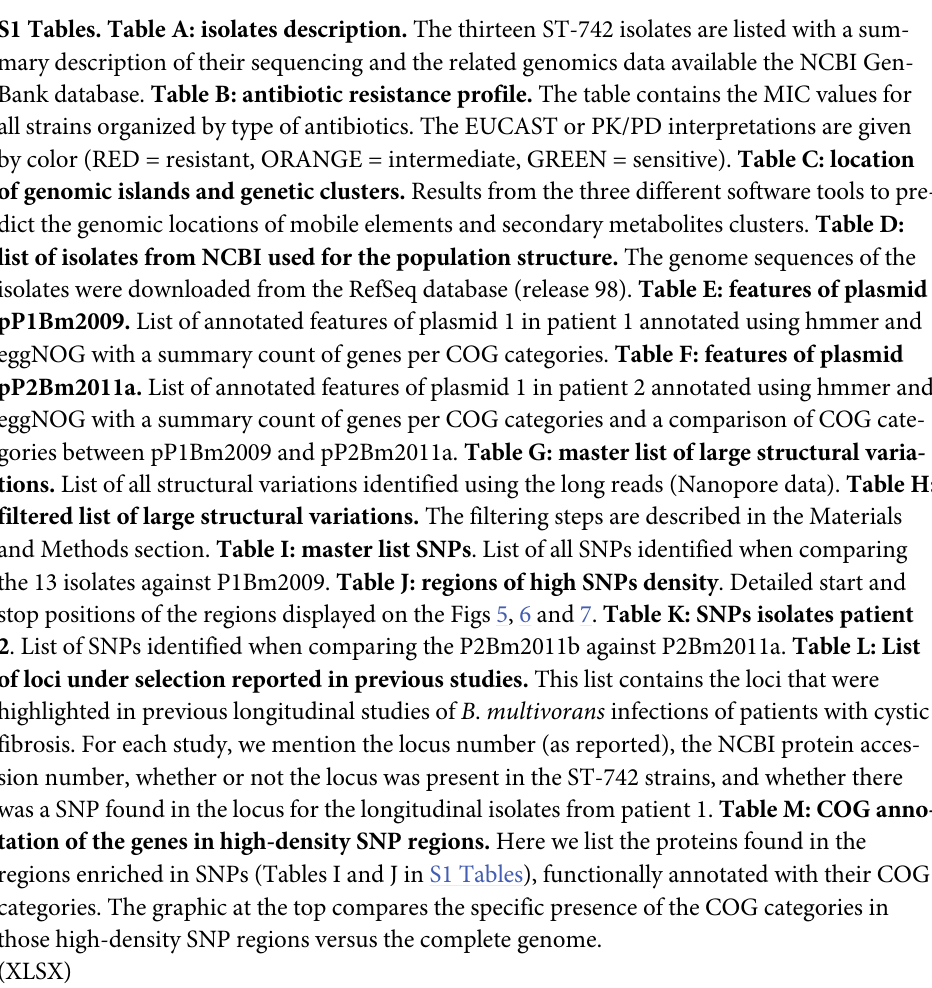
S1 Tables. Table A: isolates description. The thirteen ST-742 isolates are listed with a sum- mary description of their sequencing and the related genomics data available the NCBI Gen- Bank database. Table B: antibiotic resistance profile. The table contains the MIC values for all strains organized by type of antibiotics. The EUCAST or PK/PD interpretations are given by color (RED = resistant, ORANGE = intermediate, GREEN = sensitive). Table C: location of genomic islands and genetic clusters. Results from the three different software tools to pre- dict the genomic locations of mobile elements and secondary metabolites clusters. Table D: list of isolates from NCBI used for the population structure. The genome sequences of the isolates were downloaded from the RefSeq database (release 98). Table E: features of plasmid pP1Bm2009. List of annotated features of plasmid 1 in patient 1 annotated using hmmer and eggNOG with a summary count of genes per COG categories. Table F: features of plasmid pP2Bm2011a. List of annotated features of plasmid 1 in patient 2 annotated using hmmer and eggNOG with a summary count of genes per COG categories and a comparison of COG cate- gories between pP1Bm2009 and pP2Bm2011a. Table G: master list of large structural varia- tions. List of all structural variations identified using the long reads (Nanopore data). Table H: filtered list of large structural variations. The filtering steps are described in the Materials and Methods section. Table I: master list SNPs . List of all SNPs identified when comparing the 13 isolates against P1Bm2009. Table J: regions of high SNPs density . Detailed start and stop positions of the regions displayed on the Figs 5, 6 and 7. Table K: SNPs isolates patient 2 . List of SNPs identified when comparing the P2Bm2011b against P2Bm2011a. Table L: List of loci under selection reported in previous studies. This list contains the loci that were highlighted in previous longitudinal studies of B . multivorans infections of patients with cystic fibrosis. For each study, we mention the locus number (as reported), the NCBI protein acces- sion number, whether or not the locus was present in the ST-742 strains, and whether there was a SNP found in the locus for the longitudinal isolates from patient 1. Table M: COG anno- tation of the genes in high-density SNP regions. Here we list the proteins found in the regions enriched in SNPs (Tables I and J in S1 Tables), functionally annotated with their COG categories. The graphic at the top compares the specific presence of the COG categories in those high-density SNP regions versus the complete